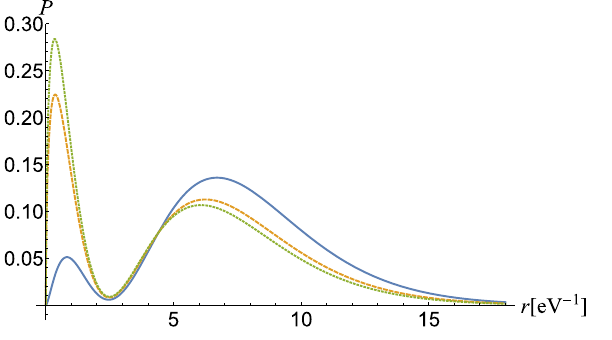
2 in a curved space of normalized wave functions for energy ( r ) � c r 2 a | = | 0 (continuous) corresponds to the flat space. As the b parameter increases, = 5 and the green one (dotted) to b =